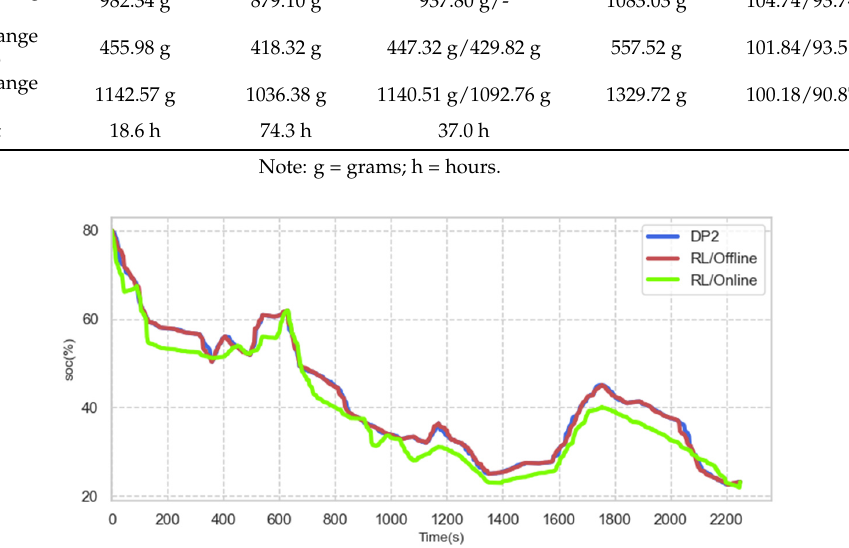
Figure 21. SOC tracking record of short flight mission.